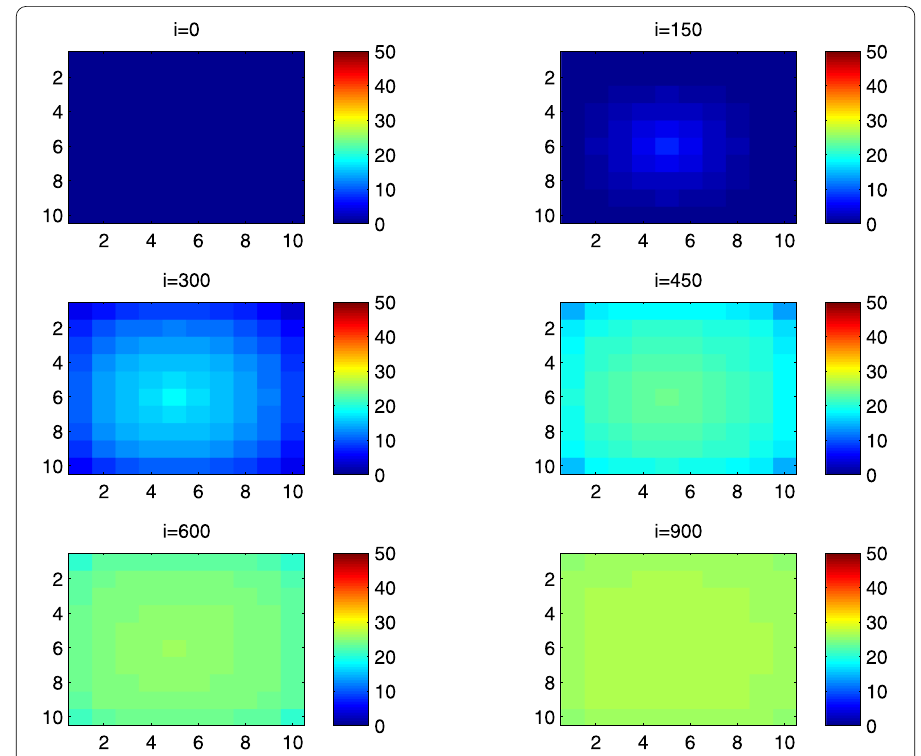
Figure 7 R Cpq behavior in the absence of control. The case when the disease starts from the center of (cid:2) .